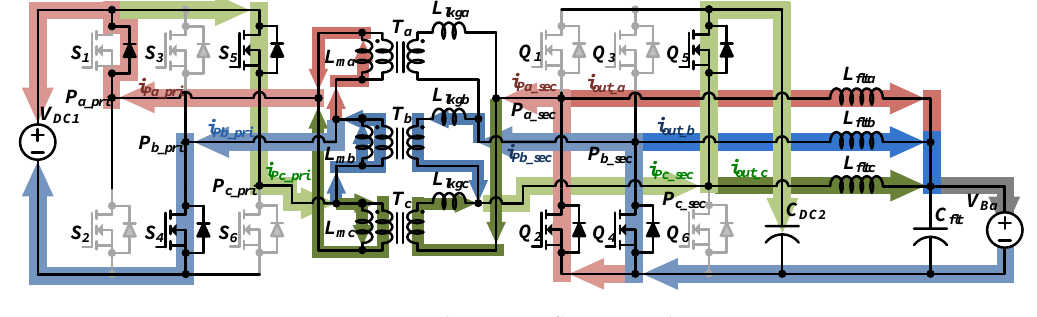
Electronics 2018 , 7 , x FOR PEER REVIEW